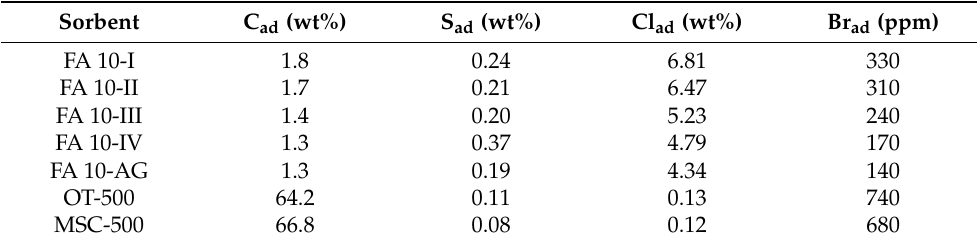
Table 4. Sorption relevant chemical content of the analysed